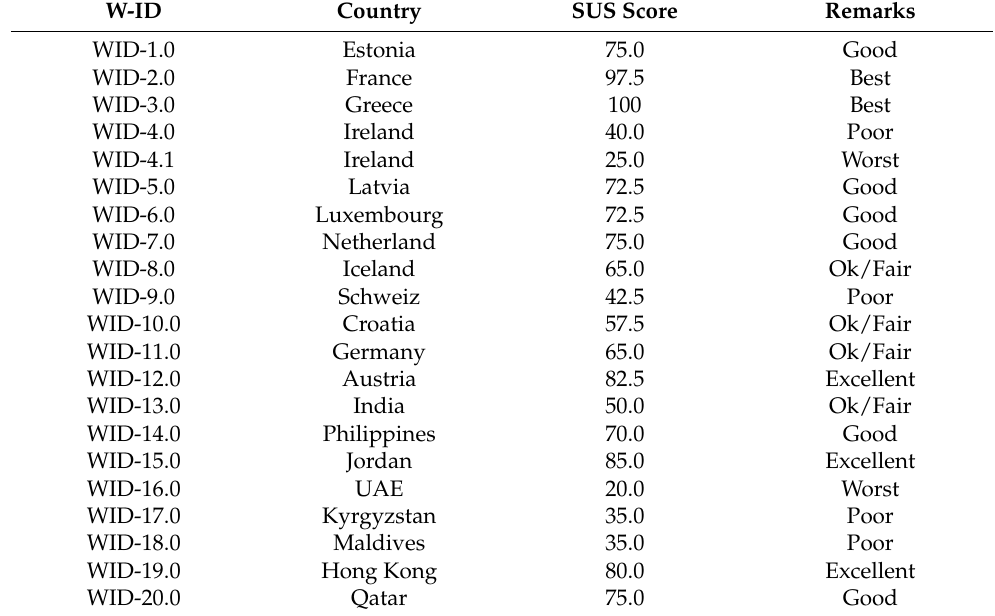
Table 9. SUS result of targeted websites.